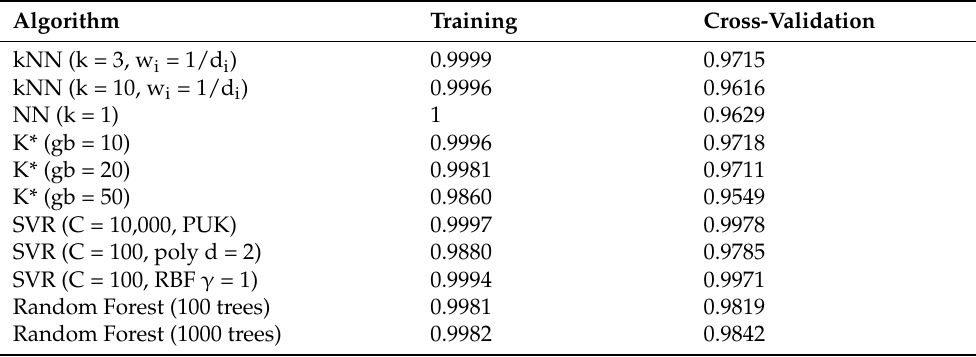
Table 6. The results obtained with several regression